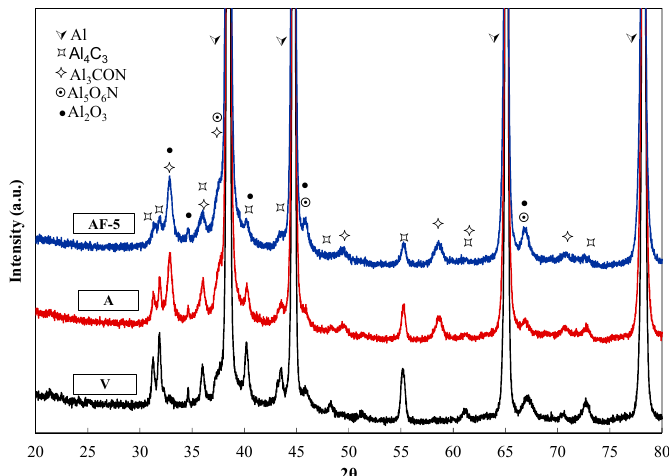
Figure 6. X ‐ ray diffraction patterns of mechanically alloyed Al powders after sintering. Figure 6. X-ray diffraction patterns of mechanically alloyed Al powders after sintering.